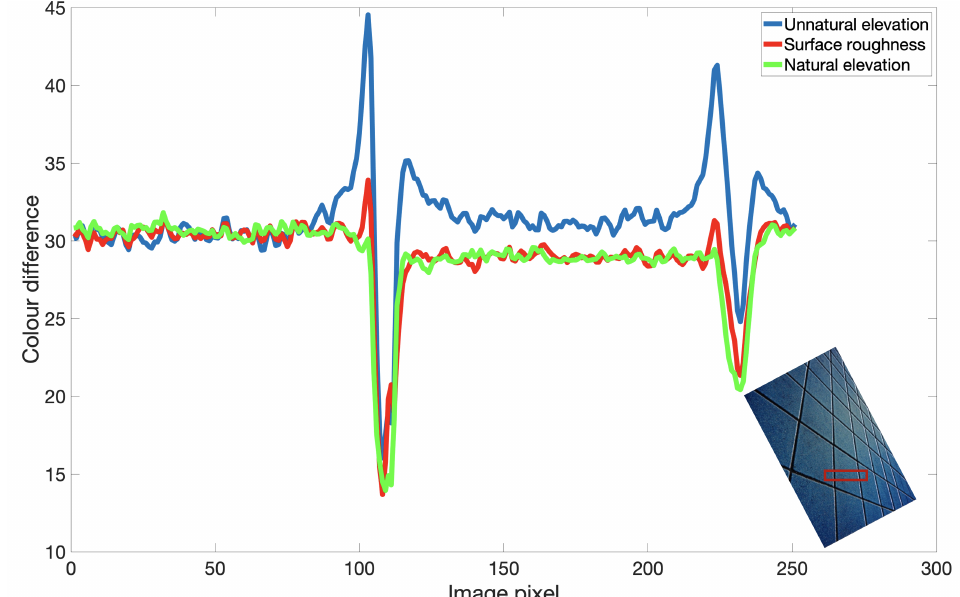
Figure 8. The line profile of the grout line (around 105 to 115 pixels) from the MS captures from SCIELAB. The image (rotated to − 65 ◦ ) on bottom right side shows approximate location, in red, of the extracted grout line in the tiles image. Zero means there is no color